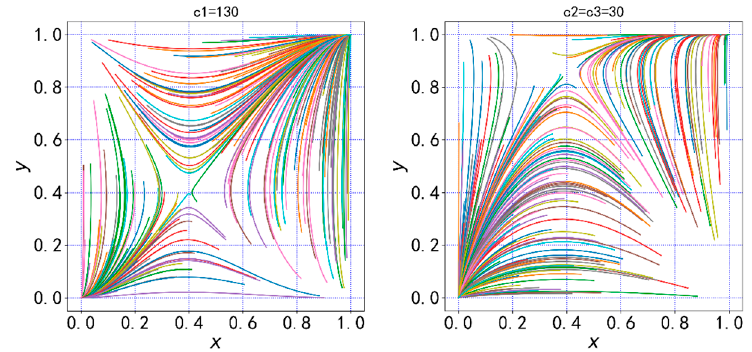
Figure 6. Simulation results chart for (cid:1855) (cid:2869) = 130 and (cid:1855) (cid:2870) = 30, (cid:1855) (cid:2871) = 30 . About the joint fraudulent loan allocation rate to SMEs (cid:1863) and the credit block incen- tives (cid:1874) (cid:2869) : When maintaining the other parameters’ values and increasing the combined